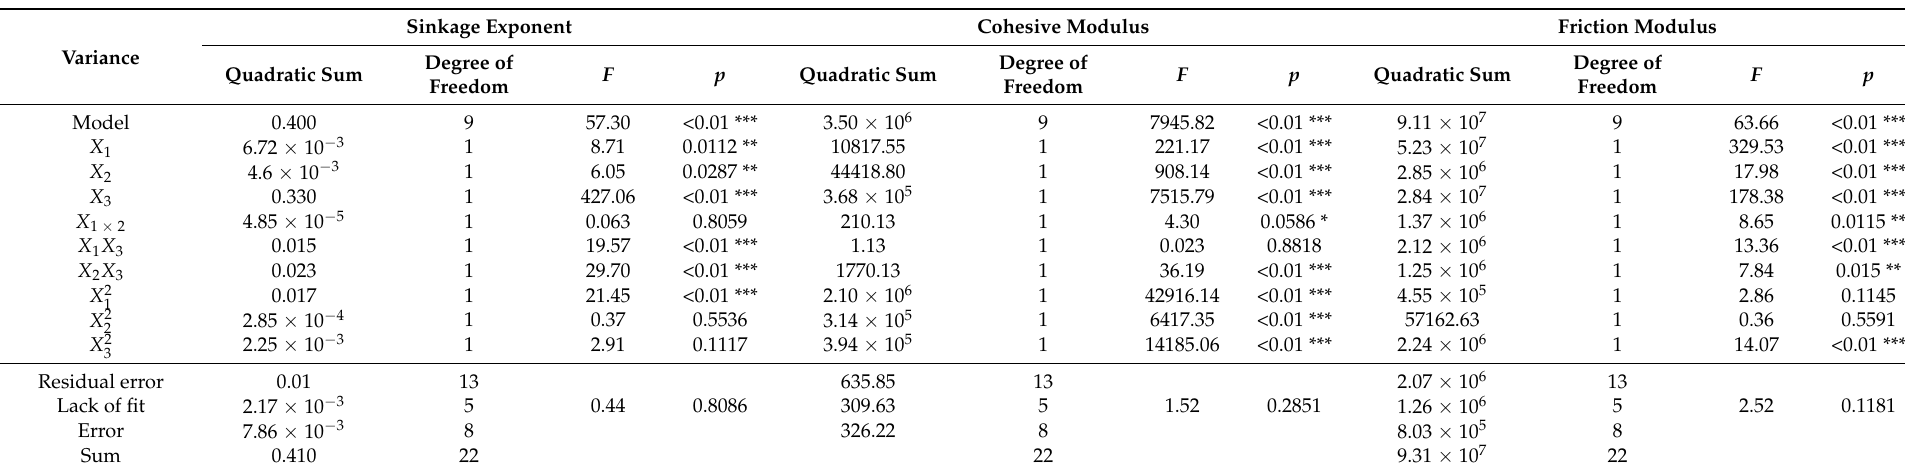
Table 6. Analysis of